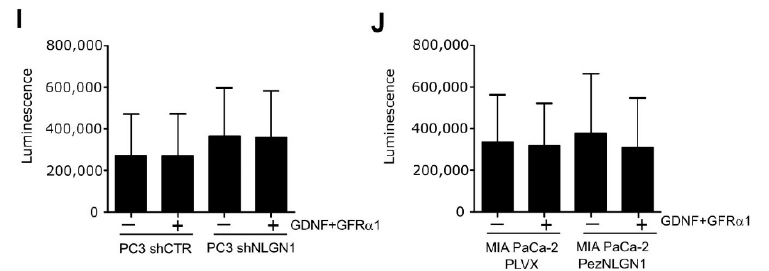
Figure 3. NLGN1 and GDNF act synergistically in tumor–nerve connections. ( A , B ) Co-culture of murine DRG with PC3 shCTR ( A ) or MIA PaCa2 PezNLGN1 ( B ) cells in absence or in presence of a blocking antibody against GFR α 1. Black arrowheads in magnifications indicate PC3 shCTR ( A ) and MIA PaCa-2 PezNLGN1 ( B ) cancer cells contacting and migrating along the neurites toward the DRG body in absence of the GFR α 1-blocking antibody. In the presence of GFR α 1-blocking antibody, neurites appear free of invading cells (right panels in ( A , B ) with magnifications), which instead localize at the periphery of the well. Pictures were taken after 72 h and are representative of 1 out of 3 reproducible experiments performed in quadruplicate (original magnification 2.5 × ). ( C – F ) Migration ( C , D ) and invasion ( E , F ), through a 10 µ g/mL layer of Matrigel, of PC3 shCTR and PC3 shNLGN1 ( C , E ) or MIA PaCa-2 PLVX and MIA PaCa-2 PezNLGN1 ( D , F ) by XCELLigence. Histograms show the migration and invasion rate in terms of cell index at the experimental end point (24 h) and values are expressed as the mean ± SE of 3 independent experiments performed in quadruplicate. One-way ANOVA with Bonferroni test: *, p < 0.05 **, p < 0.01, ***, p < 0.001. ( G , H ) Invasion rate of PC3 shCTR ( G ) or MIA PaCa-2 PezNLGN1 ( H ) assessed by XCELLigence in absence or presence of a GFR α 1-blocking antibody. Graphs show the invasion rate in terms of cell index in time (hours) and values are expressed as mean ± SE of 2 independent experiments performed in quadruplicate. One-way ANOVA with Bonferroni test: *, p < 0.05 **, p < 0.01, ***, p < 0.001. ( I , J ) Cell proliferation, assessed by the Cell Titer Glo assay, of PC3 shCTR and PC3 shNLGN1 ( I ) or MIA PaCa-2 PLVX and MIA PaCa-2 PezNLGN1 ( J ). Graphs show the luminescence as arbitrary